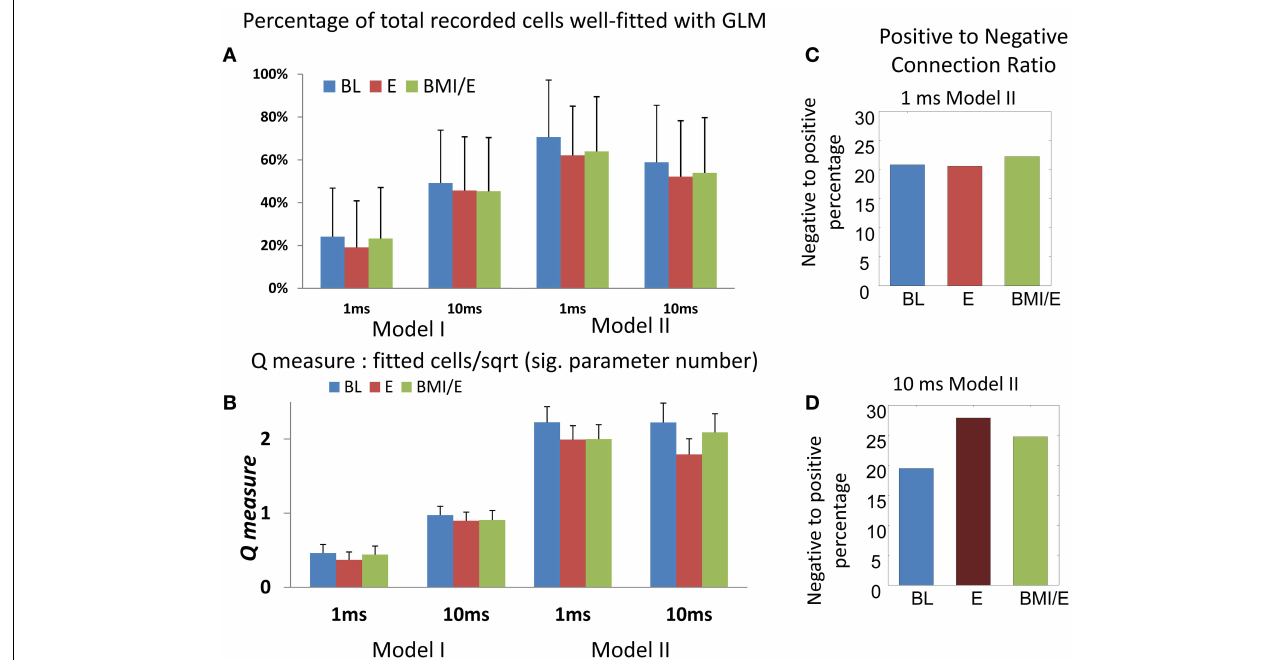
FIGURE 2 | Numbers of cells fitted with GLM model and Q-measure. ( A ) Percentage of total cells from the whole population ( n = 573 ) fitted in each model and adaptation condition. The model II with 1ms timescale had the highest capture of cells and best Q (indicated with the red dotted box). Note that despite good overall fits, only about 15% of neurons with firing interval statistics not captured by a mean rate parameter (non-Poisson firing) were well-predicted in the GLM networks here. More total and non-Poisson cells were fitted in the E condition than in the other two conditions (BL or BMI/E) at both short timescale (1ms binning) and long timescale (10ms binning). (B) The Q-measure. This was defined as the ratio of the percentage of neurons with non-Poisson firing that were well-predicted using the model, to the square root of the significant